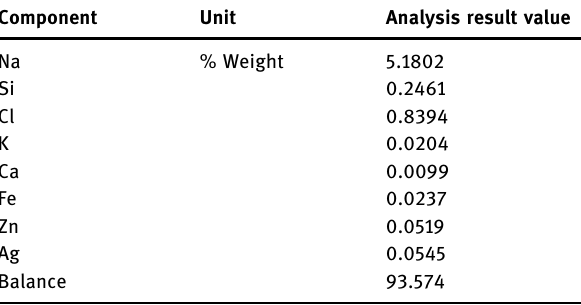
Table 2: XRF Analysis of Ferrate